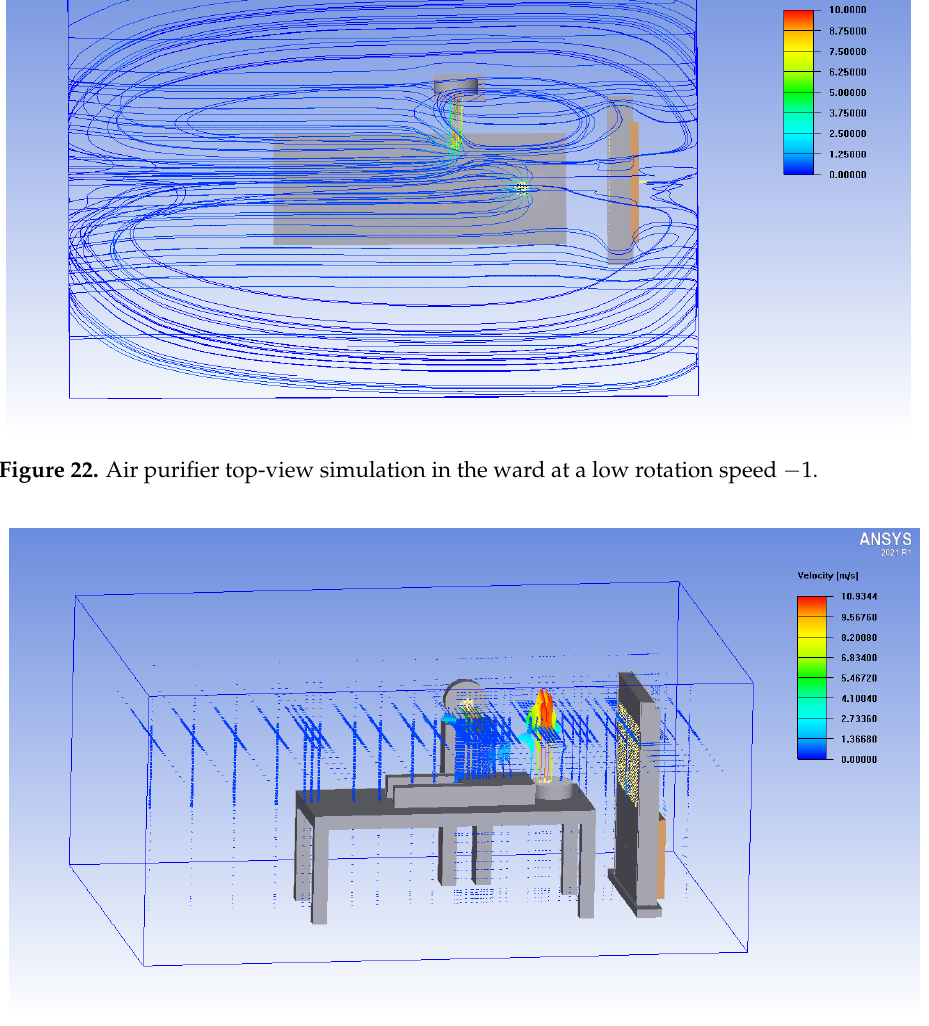
Figure 23. Air purifier top-view simulation in the ward at a low rotation speed -2.